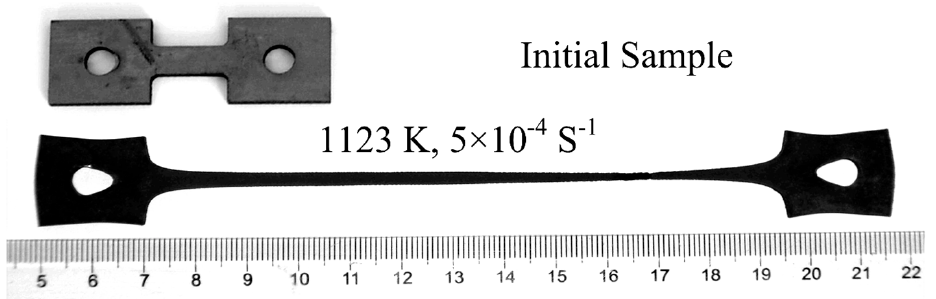
Figure 5. Macrogaraphs of Ti-6Al-4V alloy before and after deformation.